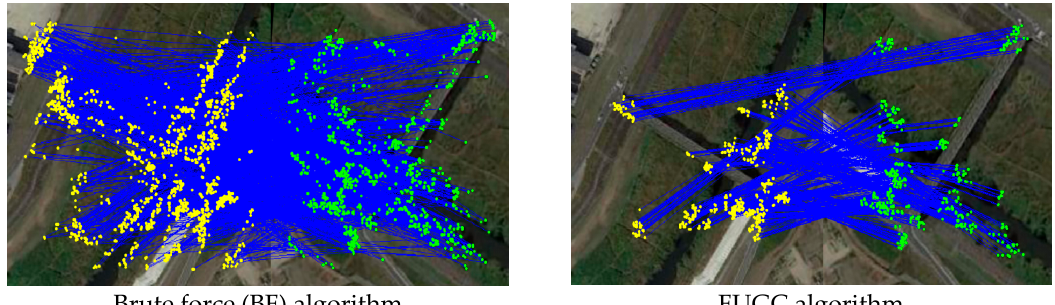
Figure 1. The image is divided into 10 × 10 non-overlapping grid cells, where the feature points in a grid cell are marked in yellow.